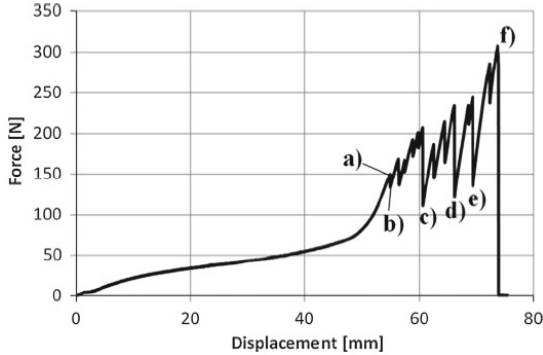
Figure 2. Results of a tensile test applied to a panto- graphic structure with a pivot height of 0.5 mm and a pivot diameter of 0.9 mm from [2].